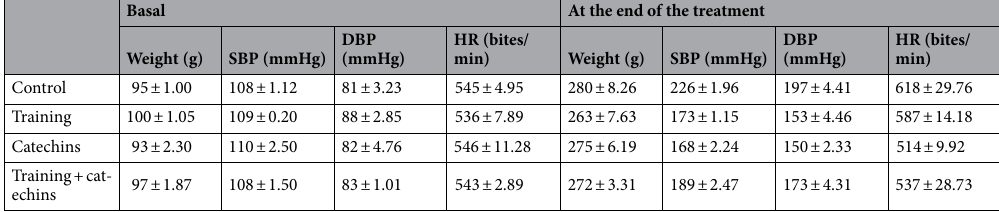
Table 1. Parameters measured in the four groups at the arrival in our lab and at the end of the treatments (Means ±